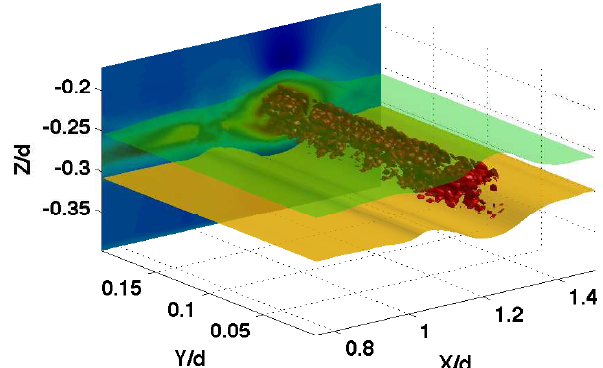
Fig. 12. Three-dimensional plot of the five percent isosurface of the maximum spanwise velocity for the symmetric case. Two iso- surfaces of density were also plotted at 25 percent above (yellow) and below (green) the average density. Finally, the average horizon- tal velocity is also displayed on the back plane of the image, nor- malized to its maximum value. Image output at t = 37 . 5s. Scaling d = 1m.